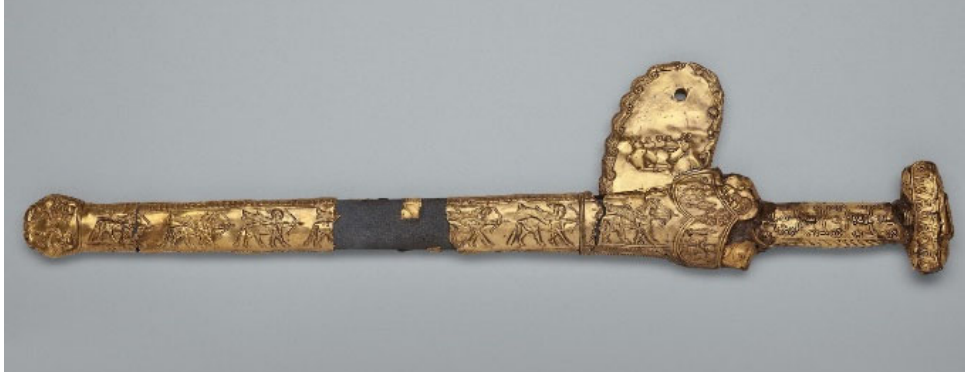
Figure 23. Sword with decorated scabbard (SHM inv. no. Дн .1763-1/19); cast and forged iron, chased gold; Melgunov (Litoi), Dnieper area, Ukraine; c. 7th century BC. [Image is used from www.hermitagemuseu m.org (accessed 9 November 2022), courtesy of the State Hermitage Museum, St. Petersburg,